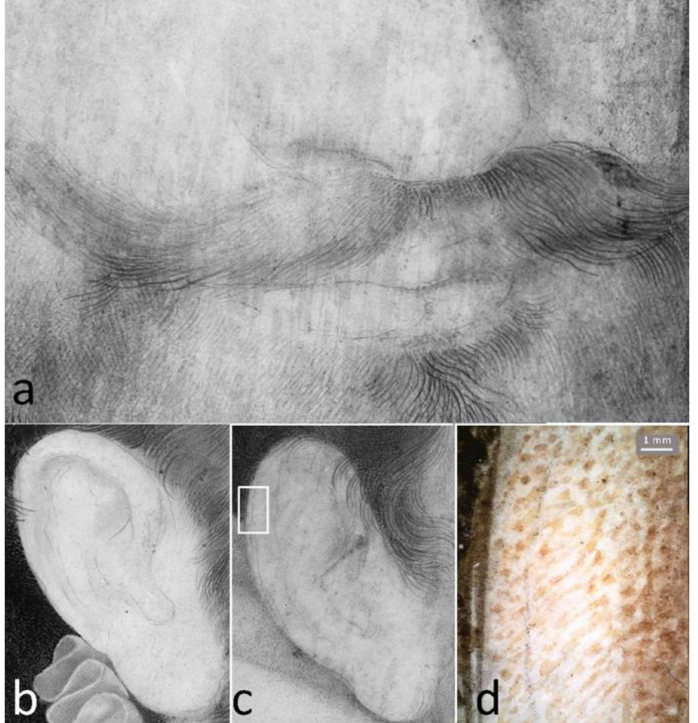
Figure 4. ( a ): SWIR image of the Portrait of Carlo Emanuele I where it is well-evident that the underdrawing was made with a metal point. Comparison of underdrawings, in correspondence of the right ear, of the portrait of ( b ) Emanuele Filiberto and ( c ) Carlo Emanuele I and ( d ) the enlarged detail of the highlighted rectangle in ( c ), with a microscopic image showing the visible trace of the metal point underdrawing emerging under the dotted